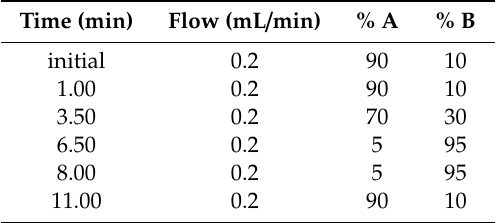
Table A1. Gradient of the mobile phase in the C18 column.